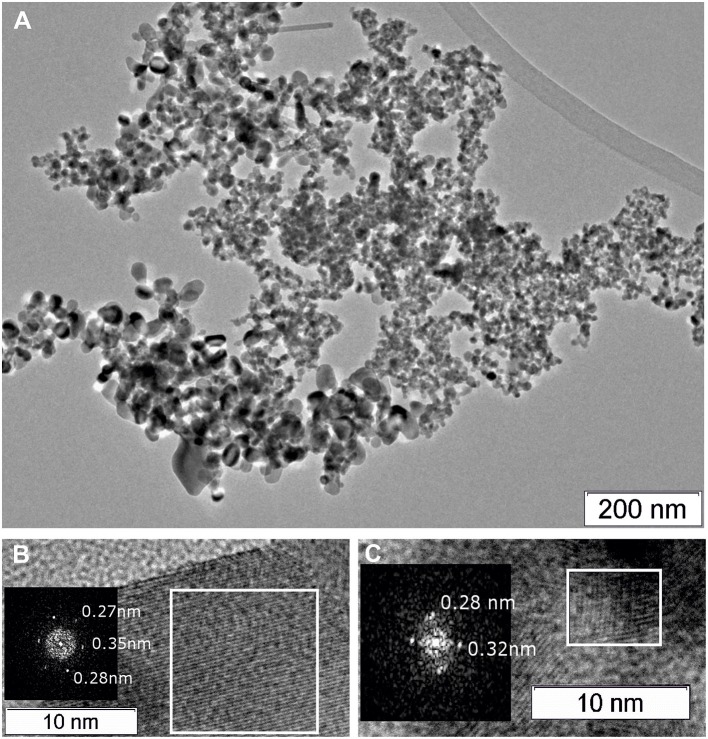
TEM images of the Pt/CeSn-600 sample (A). A HRTEM and Fourier image of the crystal lattice of the SnO2 cassiterite phase (B), HRTEM and Fourier image of the CeO2 fluorite phase (C).